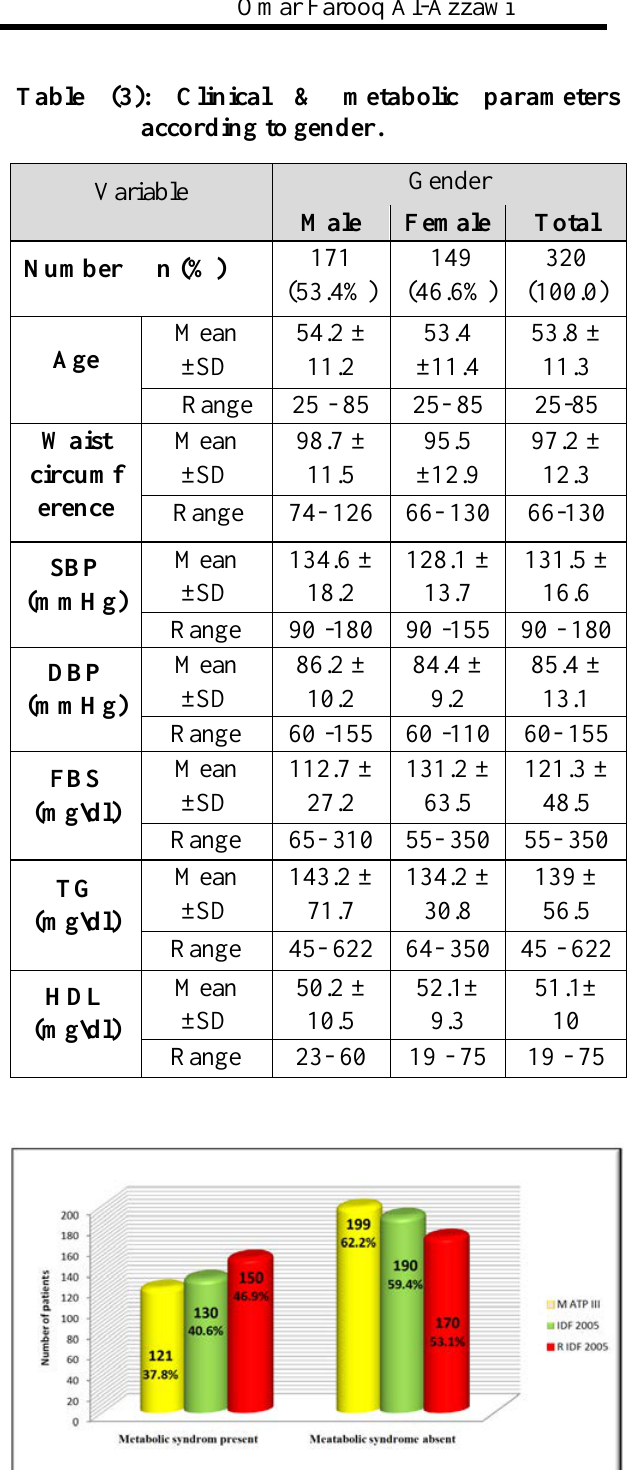
Figure 1: Prevalence of metabolic syndrome according to the three definitions among study